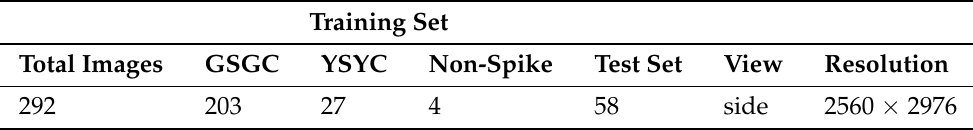
Table 3. Summary of training and test image sets used for detection and segmentation